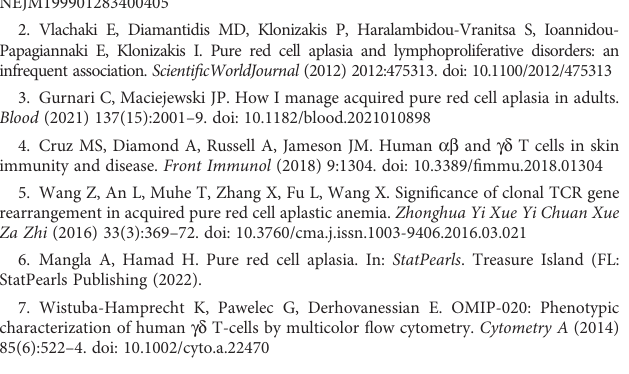
SUPPLEMENTARY FIGURE 1 Flow cytometry results before treatment. The proportion of the abnormal gd T cell clone and other cell types in the patient ’ s bone marrow before treatment. SUPPLEMENTARY FIGURE 2 Flow cytometry results after treatment. The proportion of the abnormal gd T cell clone and other cell types in the patient ’ s bone marrow after 10 months of treatment. SUPPLEMENTARY FIGURE 3 Monoclonal rearrangement map of this patient (partial).Monoclonal TCR gene rearrangement was detected in TCR b and TCR d , while multiclonal patterns were also detected in TCR b